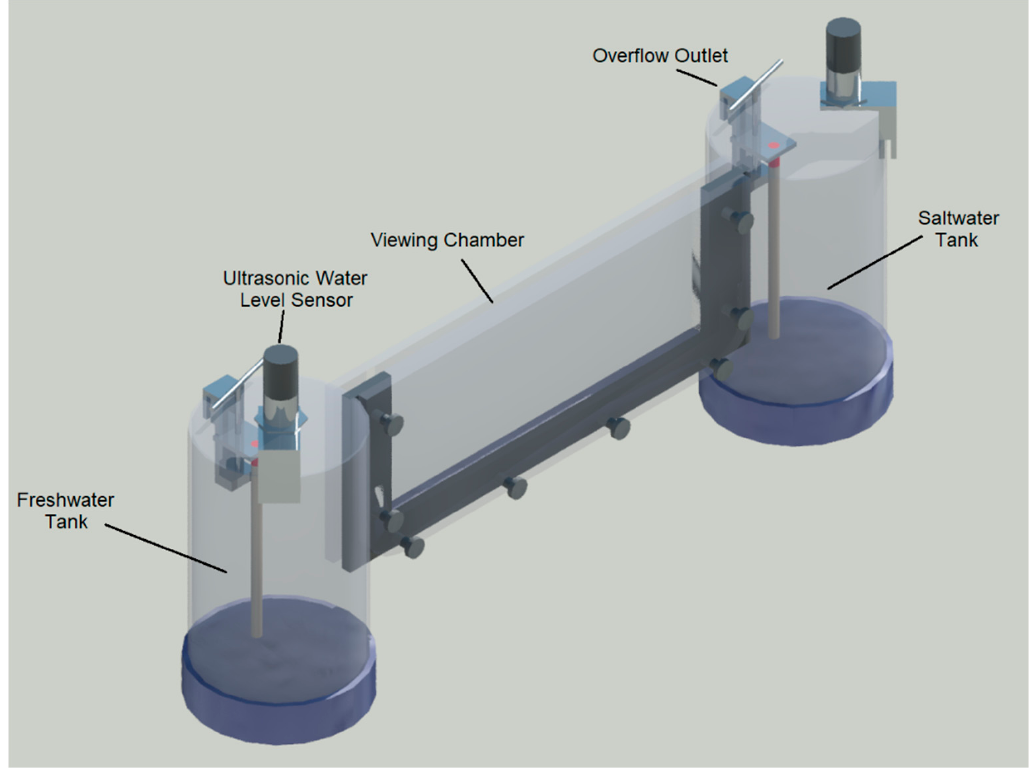
Figure 1. Three-dimensional representation of the sandbox tank.